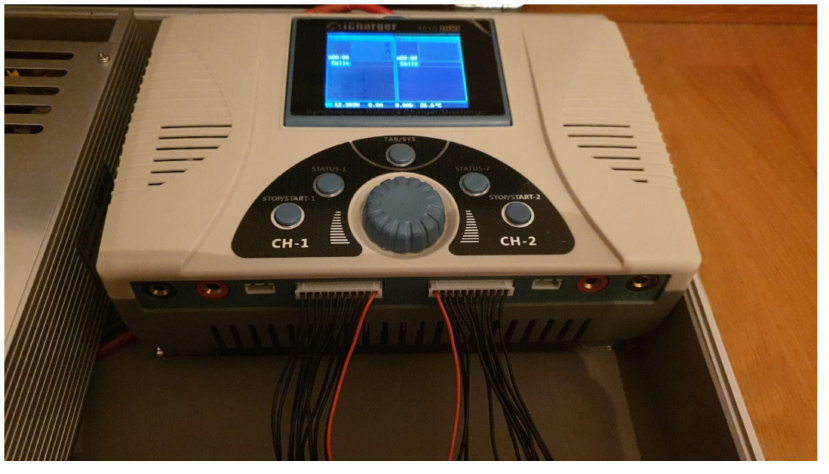
Figure 1. Icharger 4010 duo